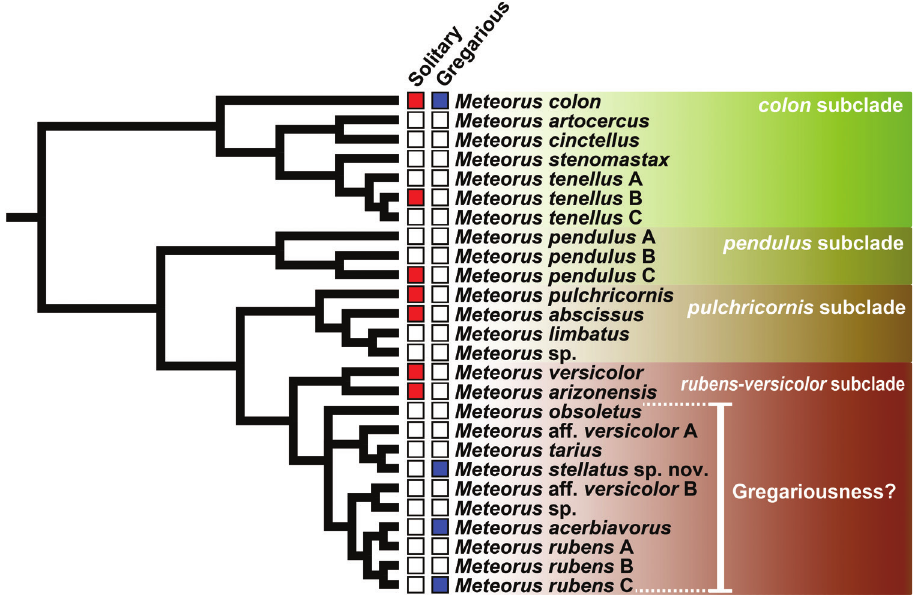
Figure 10. Phylogenetic relationships among the species of pulchricornis clade and their